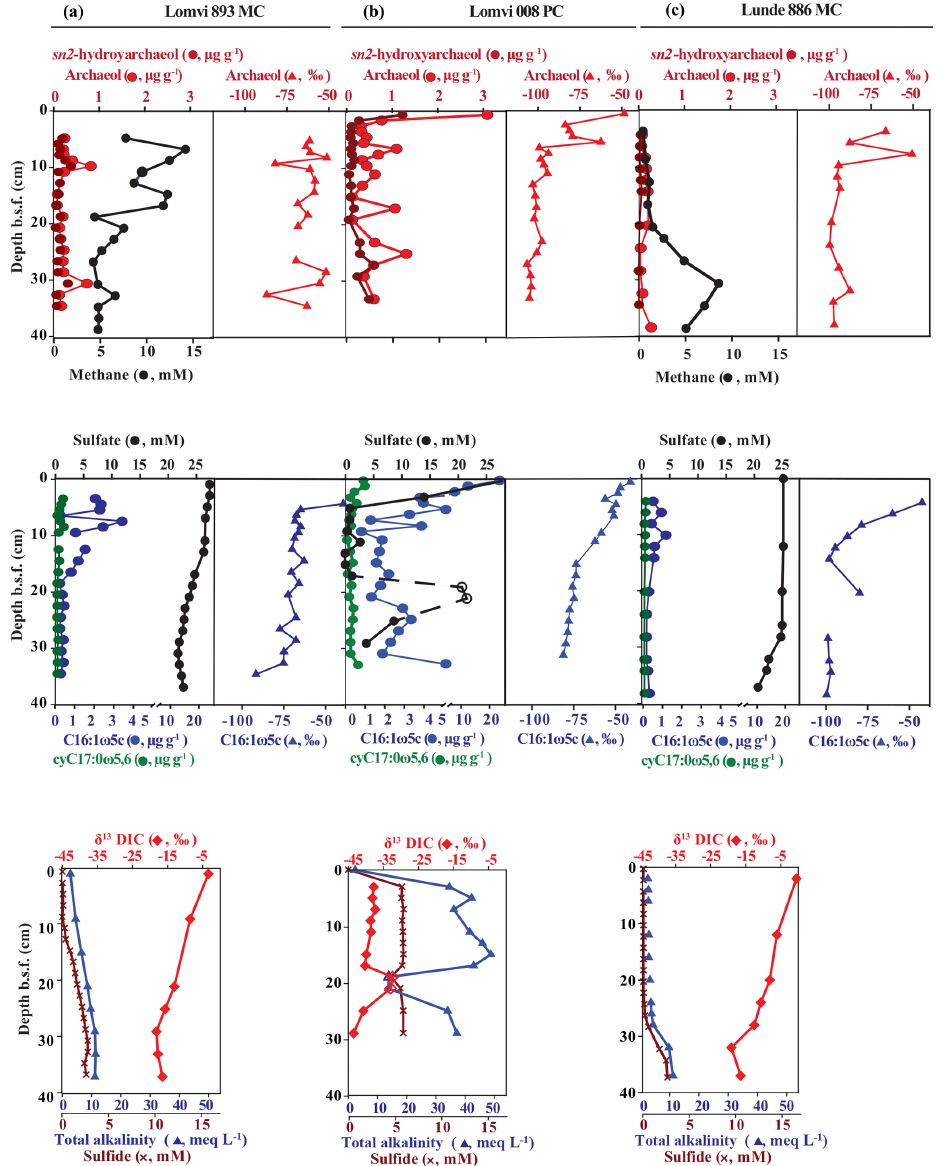
Figure 4. Biogeochemical profiles of archaeal ( sn2 -hydroxyarchaeol, archaeol) and bacterial lipid biomarkers (fatty acids C16 : 1 ω 5c, cyC17 : 0 ω 5 , 6), methane, and pore water constituents (sulfate, sulfide, DIC, and total alkalinity) in the three cores: Lomvi 893MC (a) , Lomvi 008PC (b) and Lunde 886MC (c)